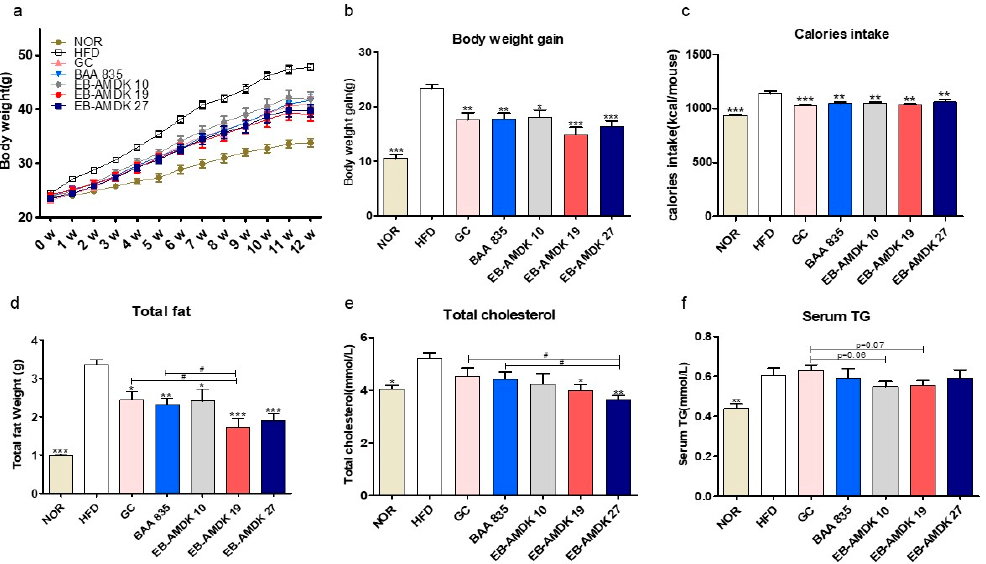
Figure 2. Effects of A. muciniphila treatment on the vital obesity parameters in high fat-diet (HFD)-fed mice. ( a ) Bodyweight measured weekly, ( b ) total body weight gain, ( c ) caloric intake, ( d ) weight of total fat (subcutaneous fat + epididymal fat + mesenteric fat), ( e ) serum level of total cholesterol (TC) and ( f ) serum triglyceride (TG) level in different experimental groups. The data are presented as the mean ± SEM ( n = 9–12). Statistical analyses were performed by one-way ANOVA or a Student’s t-test. * p < 0.05, ** p < 0.01 and *** p < 0.001 versus the HFD group. # p < 0.05.